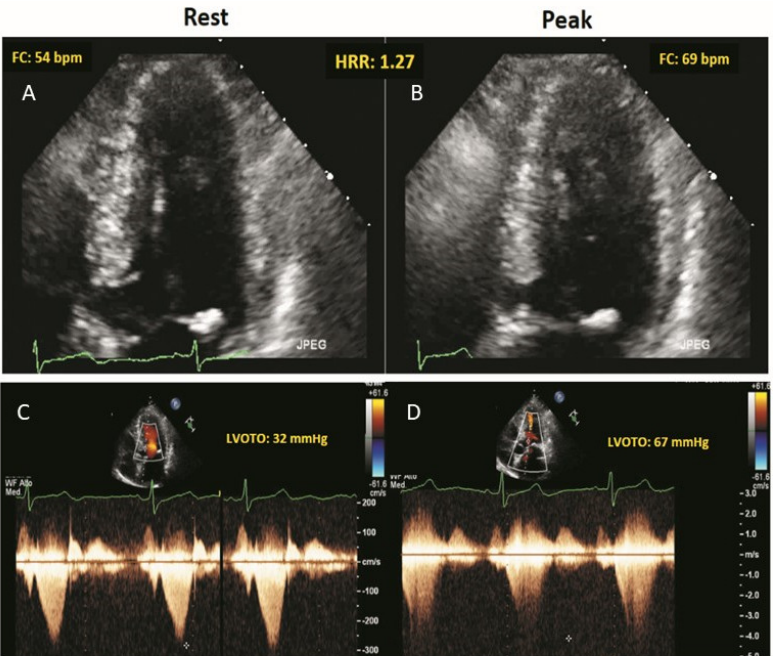
Figure 1. The stress echo protocol. Rest ( A , C ) and peak stress ( B , D ). ( A , B ): Regional function is normal. EKG lead shows a blunted HRR response (rest = 54 bpm; peak exercise = 69 bpm; HRR = 1.27). ( C , D ): Continuous wave Doppler tracing of LVOTG (rest = 32 mmHg; peak exercise = 67 mmHg). During ESE, the patient shows, a significant LVOTG and an abnormally reduced HRR. HCM patients in the lowest quartile showed more frequent dynamic obstruction, and poorer exercise tolerance (Table 2). Table 2. Stress clinical and echocardiographic characteristics of hypertrophic cardiomyopathy (HCM) patients. Overall Popu-